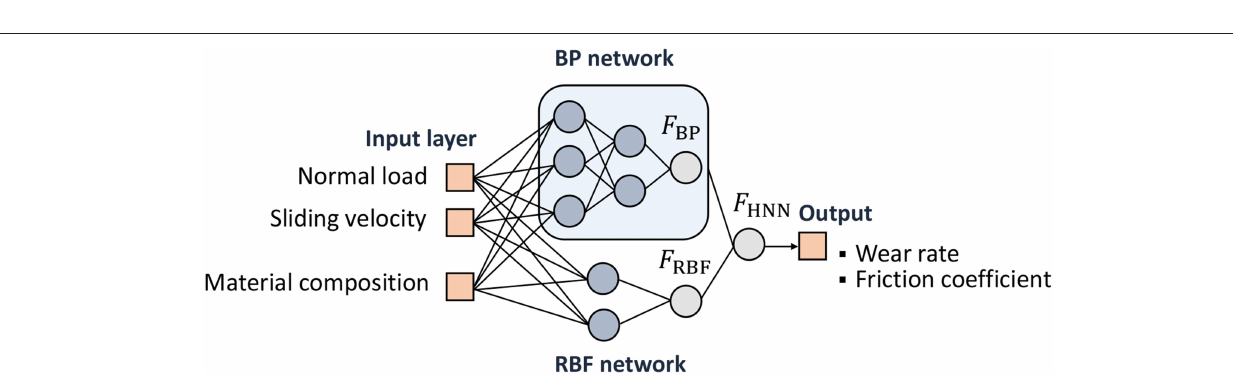
FIGURE 4 | Structure of the hybrid neural network (Li et al.,